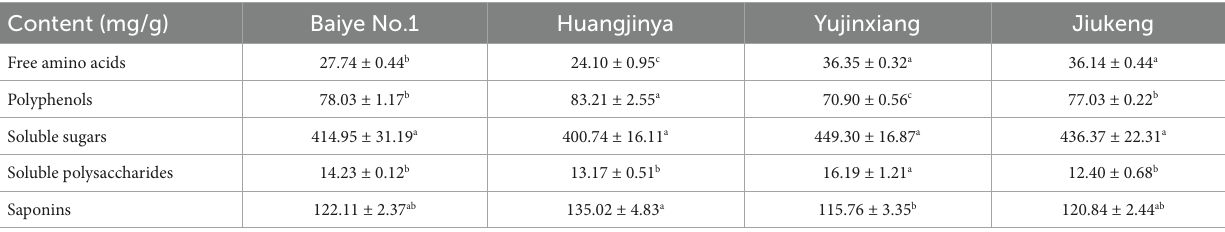
TABLE 1 The chemical compositions of four tea flowers. Content